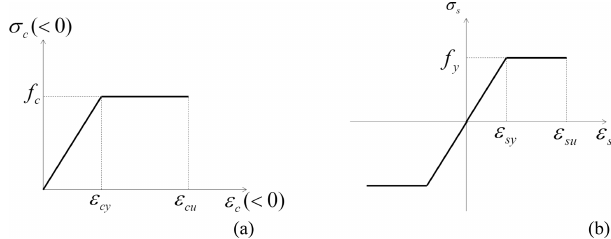
Figure 2. Stress-strain relations for concrete (a) and steel (b) .